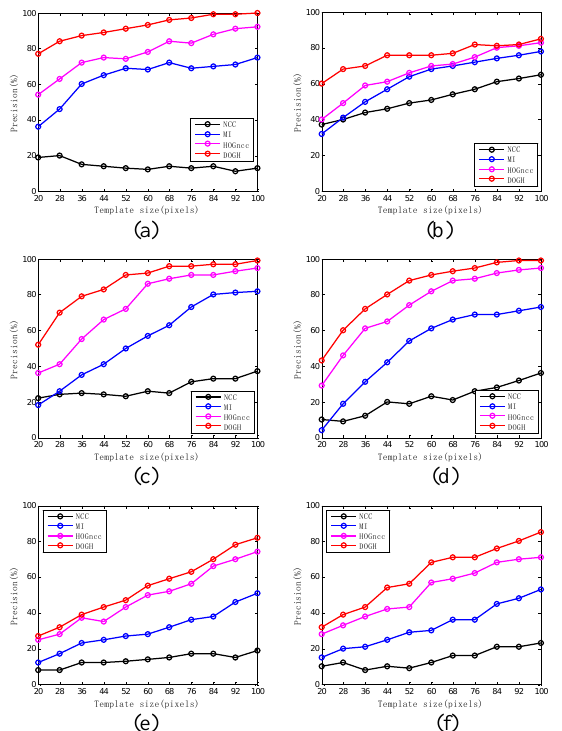
Figure 4 Precision values versus the template size of NCC, MI, HOG ncc , and DOGH for multimodal images. (a) Test 1. (b) Test 2. (c) Test 3. (d) Test 4. (e) Test 5. (f) Test 6.